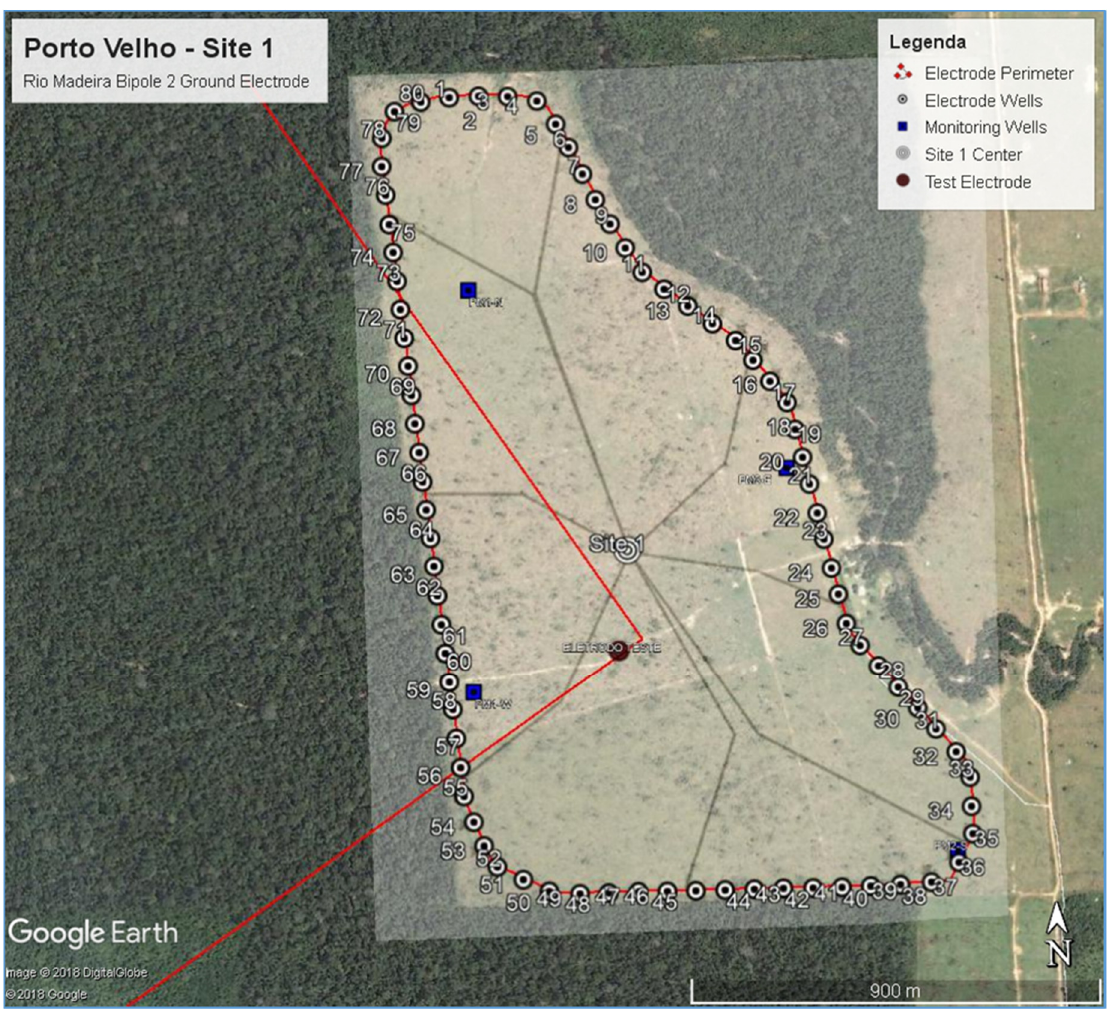
Figure 1. The ground electrode of Rio Madeira bipole 2, with its 80 wells along a 5 km asymmetric perimeter. Site 1 is the switching house and the gray lines are the buried section feeders.